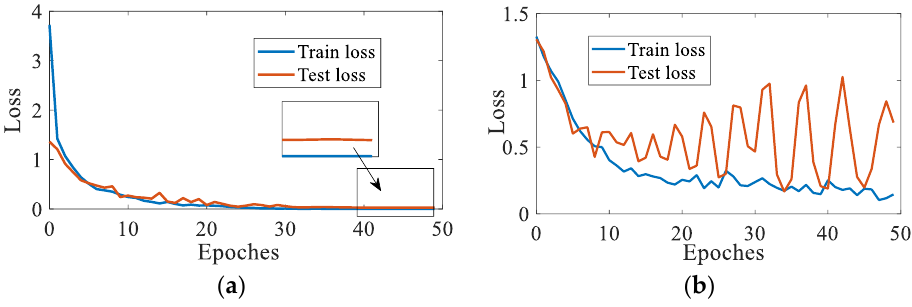
Figure 10. Loss curve ( a ) with data enhancement; ( b ) no data enhancement.